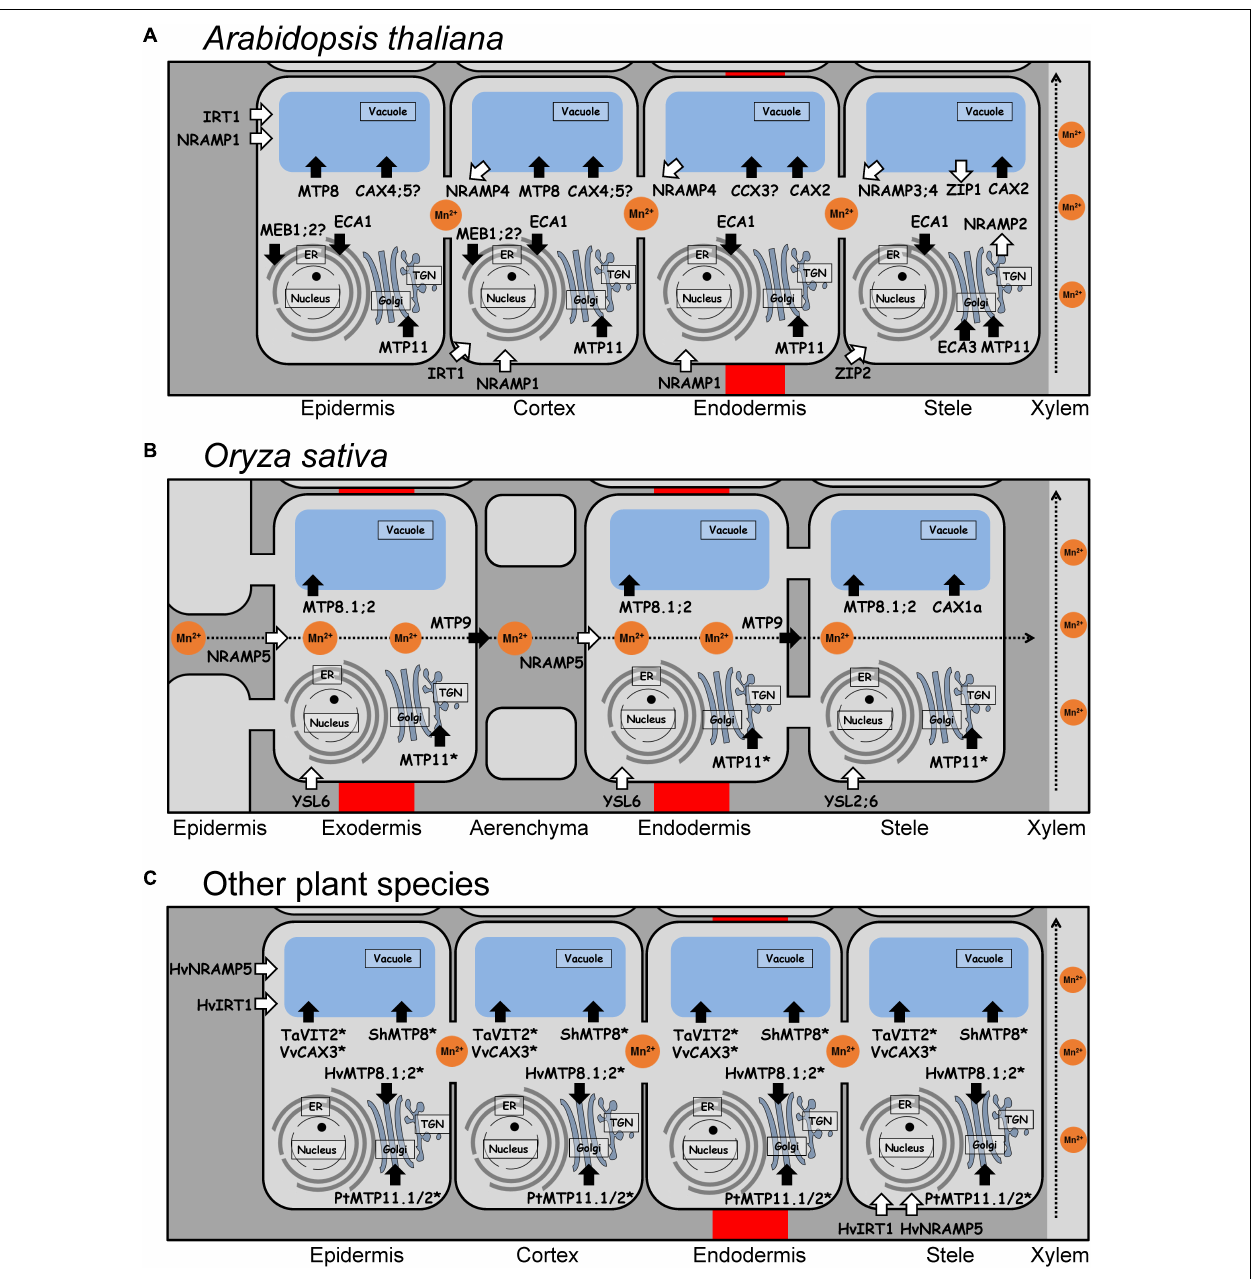
FIGURE 1 | Tissue specificity and subcellular localization of Mn transport proteins in roots of different plant species. (A) Mn transport proteins in epidermis, endodermis, cortex, and stele (including pericycle) of Arabidopsis roots. (B) Mn transport proteins in exodermis, endodermis, and stele of rice roots. Radial transport of Mn 2 + is carried out by OsNRAMP5 and OsMTP9, which are polarly localized transporters at both the exodermis and the endodermis, providing a unidirectional flux of Mn from the soil to the stele (indicated as dashed arrow). (C) Mn transport proteins in epidermis, endodermis, cortex, and stele of roots of other plant species. (A–C) White arrows indicate import into the cytosol, black arrows indicate export out of the cytosol. Transport proteins with yet unknown root tissue specificity are marked by asterisks. Proteins which subcellular localization only shown in yeast but not in plants are indicated by a question mark. Hv, Hordeum vulgare ; Pt, Populus trichocarpa ; Sh, Stylosanthes hamata ; Ta, Triticum aestivum ; Vv, Vitis vinifera